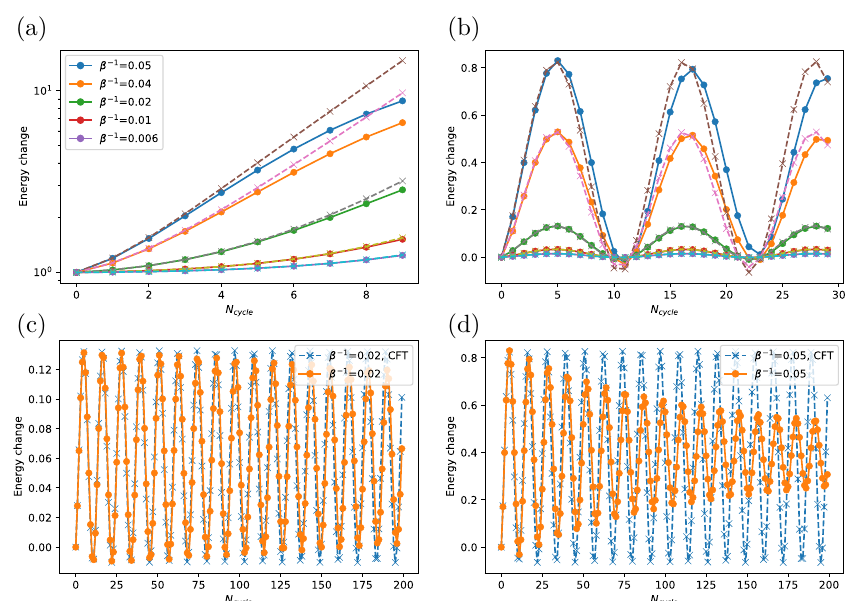
Figure 2: Energy change E ( t ) − E ( 0 ) in heating phase (a) and non-heating phase (b), for different initial temperatures, for a one dimensional chain of length L = 1000 / L | = | T / L | = 0.05. Comparison with the with periodic boundary conditions and | T 0 1 CFT time evolution at finite temperature is shown (dashed lines). The long time limit of the energy evolution is shown in the non-heating phase on the lattice (orange), compared to the CFT predictions (blue), both at initial temperature β − 1 = 0.02 (c) and β − 1 = 0.05